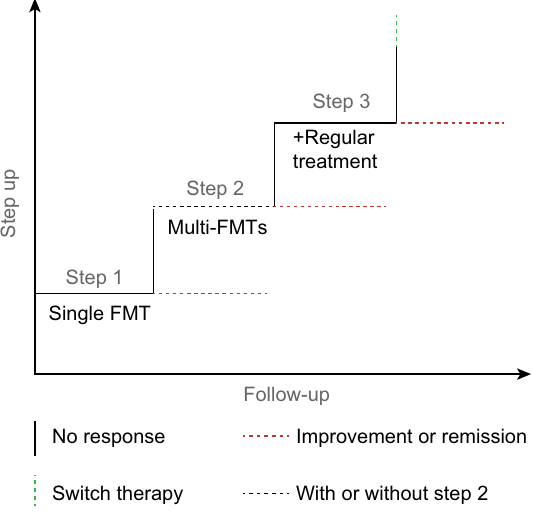
Figure 3. The step-up FMT